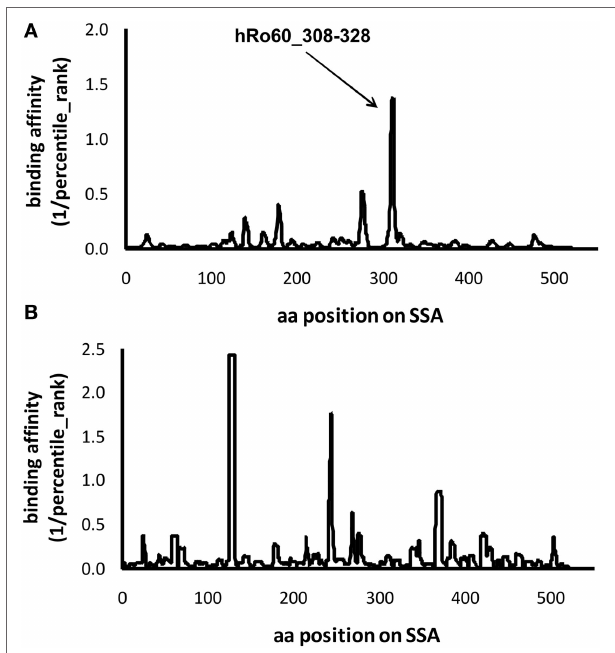
FigUre 4 | Prediction of the epitopes for the primary Sjögren’s syndrome (pSS)-risk associated HLA-DRB1 alleles within the hRo60 protein. The protein sequence of Homo sapiens Ro60 ribonucleoprote in isoform 3 (NP_001035829.2) was retrieved from the NIH database (http://www.ncbi. nlm.nih.gov/protein). By using the IEDB Analysis Resource Consensus tool, retrieved data were used to develop a prediction model that could identify the peptides binding to pSS-associated HLA-DRB1*0803 (a) and HLA- DRB1*0301 (B) alleles. The percentile rank was applied for the output, and the binding affinity to the epitope was artificially set as 1/percentile